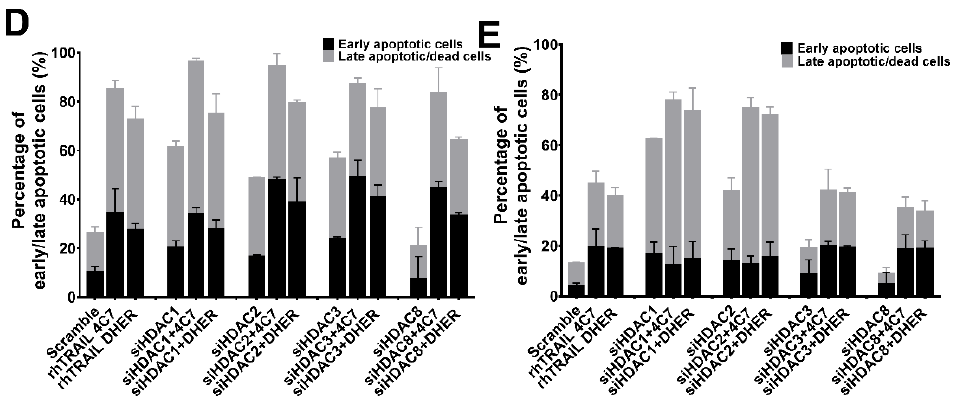
Figure 3. Knockdown of HDAC1 , 2 , 3 , or 8 enhances TRAIL sensitivity. DLD-1 ( A ) or WiDr ( B ) cells were transfected with siRNAs of scramble or HDAC1 , 2 , 3 , and 8 respectively for 72 h using Lipofectamine 2000. Relative mRNA levels were normalized by α -tubulin . The values shown are mean ± SD from one of three experiments performed in triplicate. ( C ) After 72 h transfection, DLD-1 cells were treated with 25 ng/mL rhTRAIL 4C7 or DHER and apoptotic cells were detected using the Violet Ratiometric Membrane Asymmetry Probe. The lower right group represents living cells, the lower left group represents early apoptotic cells, and the upper left group represents late apoptotic or dead cells. Statistical analysis of DLD-1 ( D ) or WiDr ( E ) cells was shown.